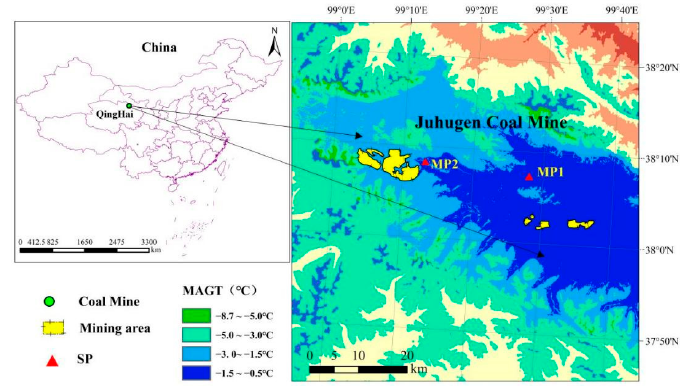
Figure 1. Schematic diagram of study area.